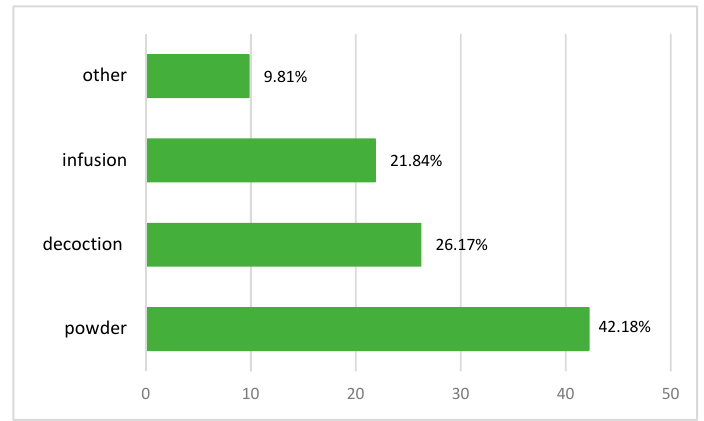
Figure 4. Recipe preparation techniques.